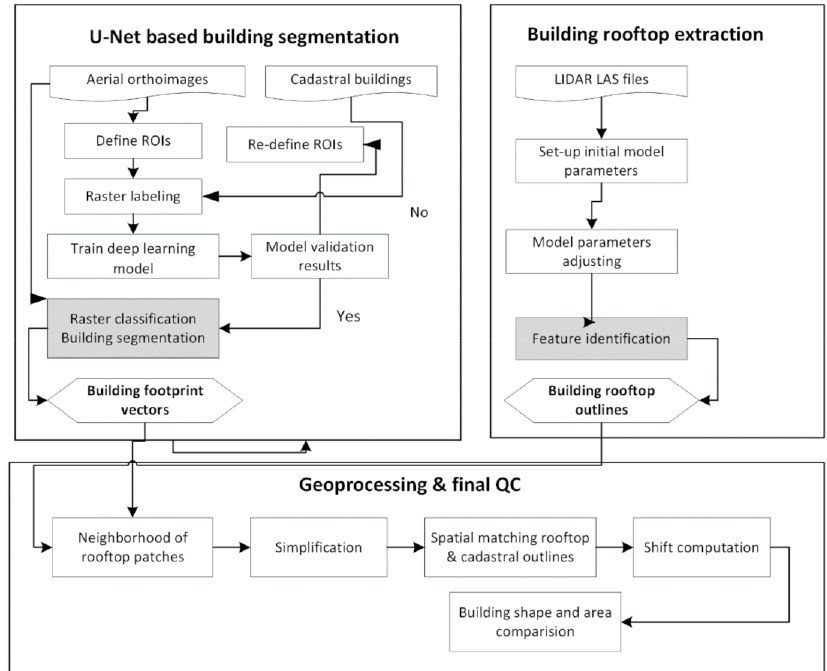
Figure 2. Schematic flow chart of the building extraction